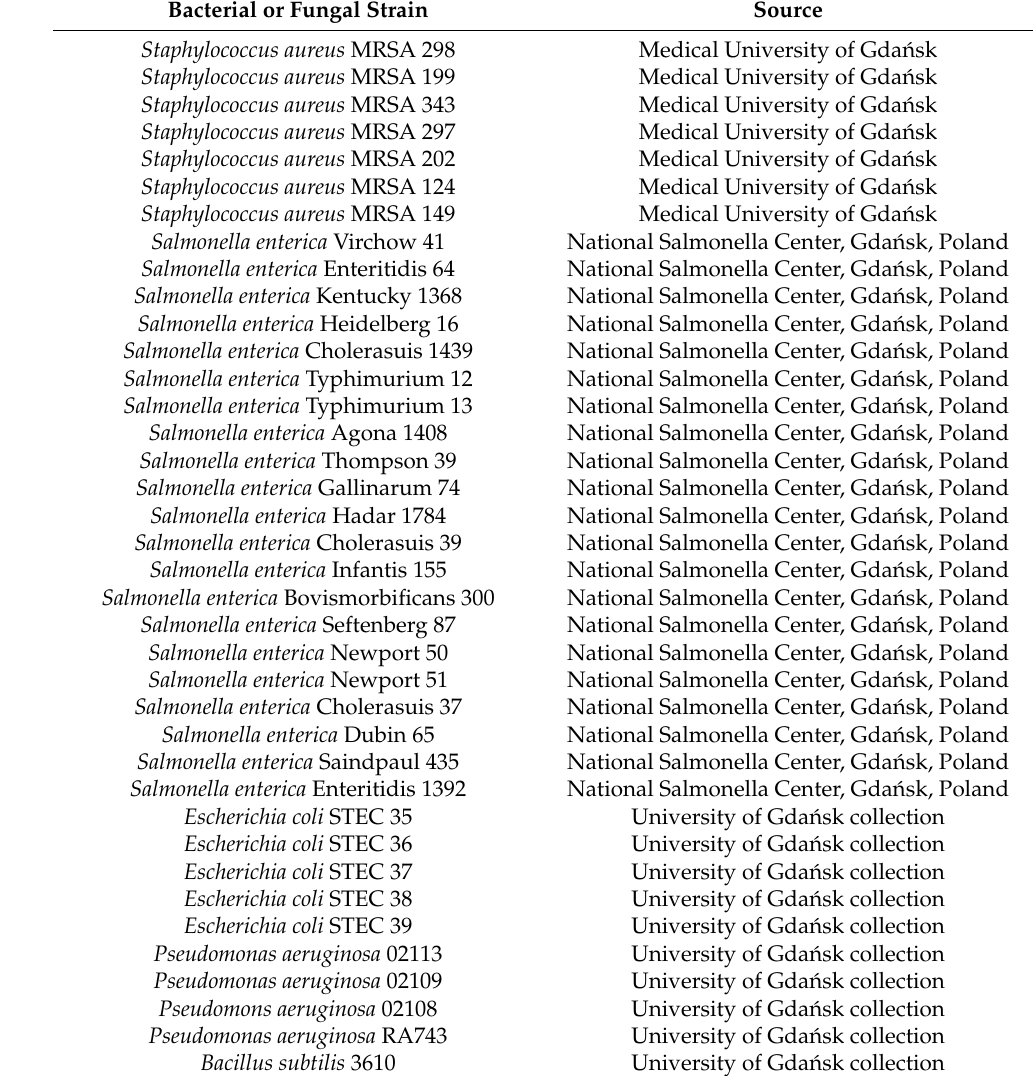
Table 2. Cont. Bacterial or Fungal